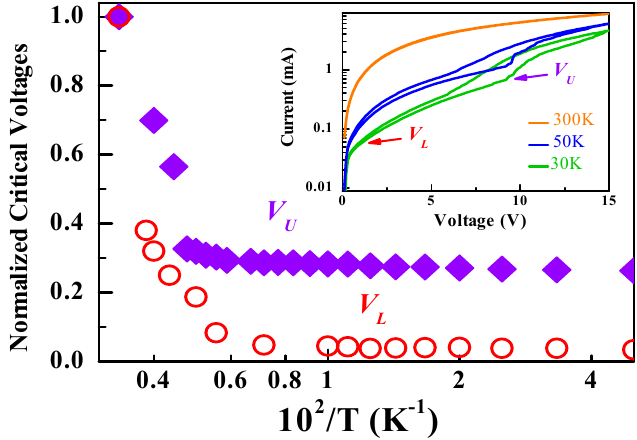
Figure 4. Temperature dependence of two critical voltages. The temperature dependence of the normalized critical voltages measured in device 1016-1# with L = 2 mm in the range of 20 K to 300 K. Insert, two SCE–RS loops at 30 and 50 K. The data measured at 300 K is presented in the insert for